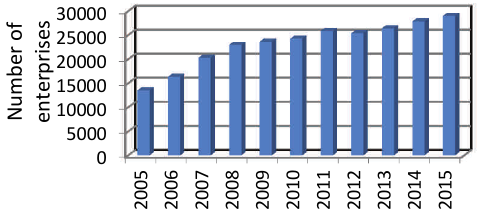
Fig. 4. Number of enterprises authorized to perform international road transport of goods (with valid licenses) between 2005 and 2015 (as of 31 December) (diagram based on GITD data [4])